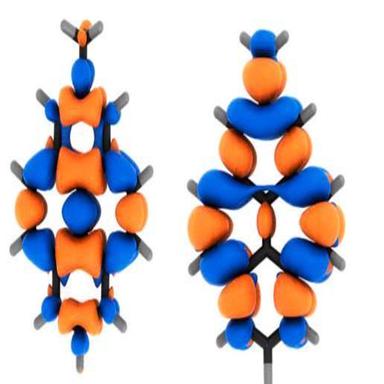
Variation of the electron density during the lowest energy transition in MePyrene (left) and Me•Pyrene (right). The blue and orange colors indicate density decrease and increase, respectively.